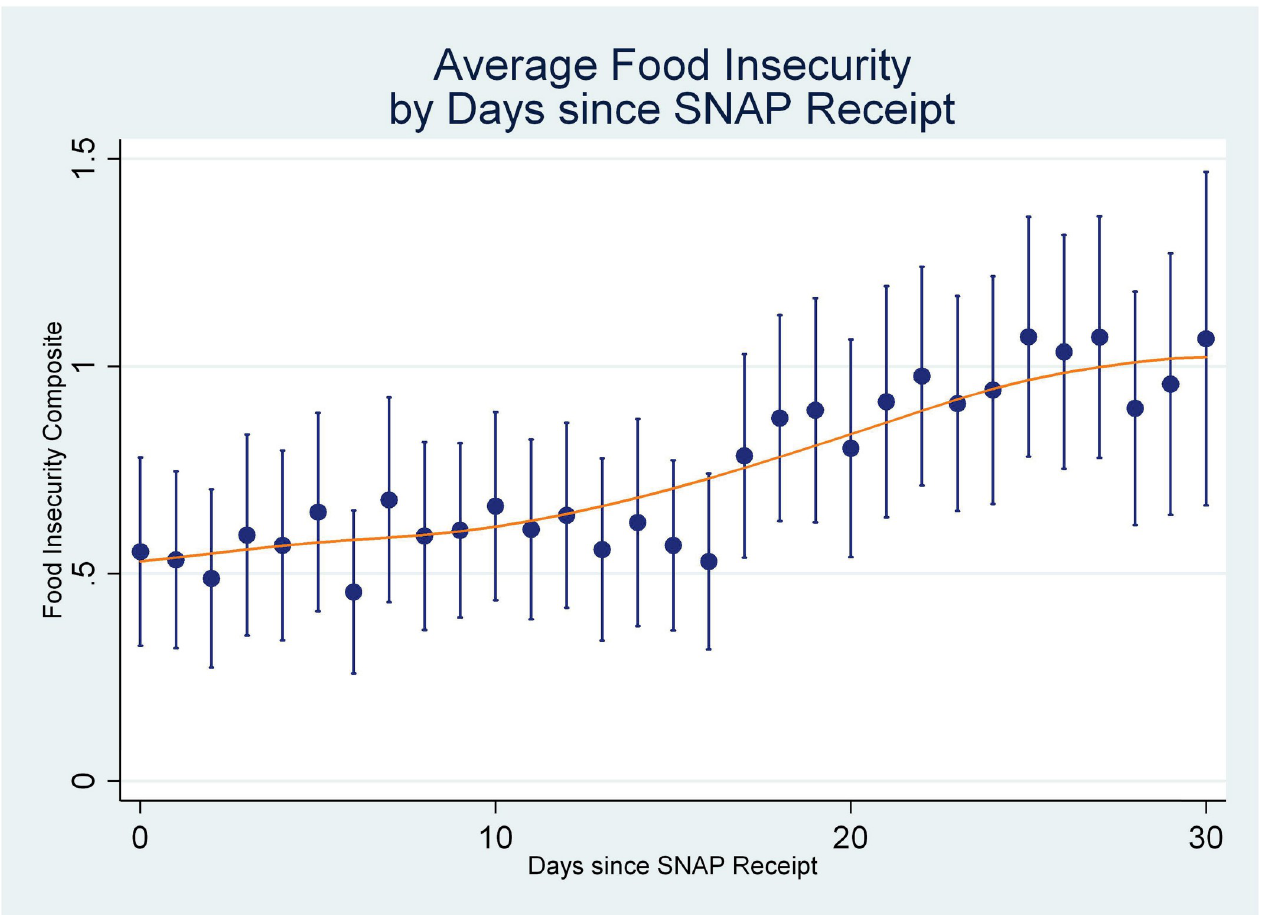
Fig 9. Average daily food insecurity by days since SNAP receipt (Gassman-Pines & Schenck-Fontaine, 2019). Source: Gassman-Pines, A. and Anika Schenck-Fontaine (2019, Fig 1). Reproduced by permission of the authors.